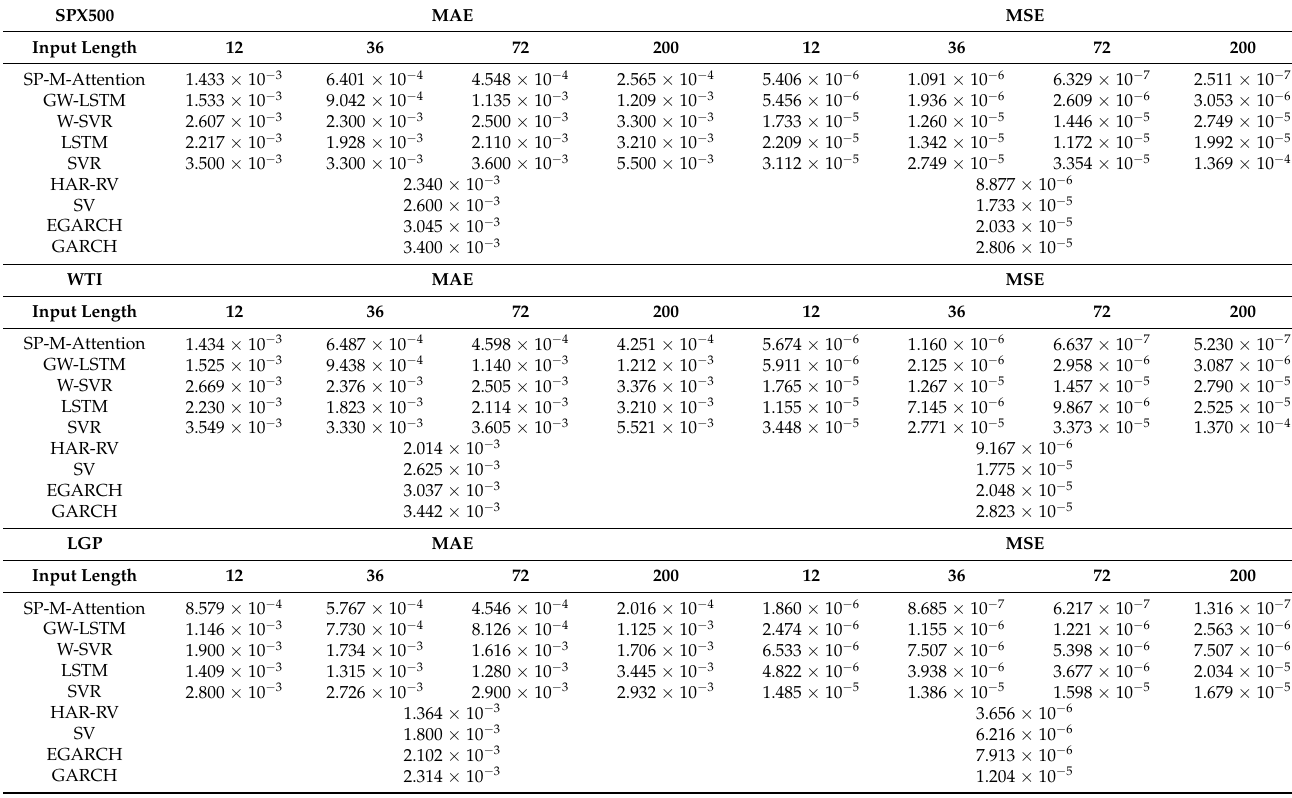
Table 3. Comparison of volatility prediction errors between SP-M-Attention and baseline under a single time series input